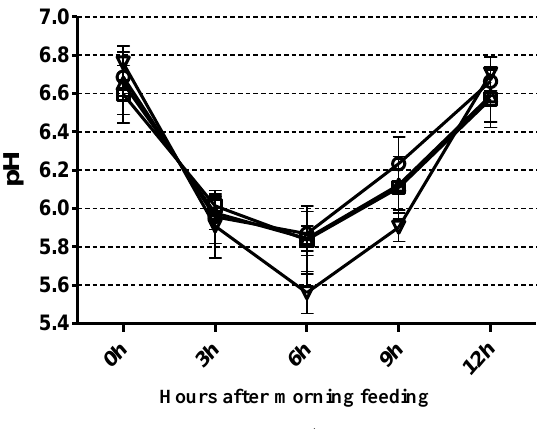
Figure 1. Diurnal patterns of rumen pH as influenced by dietary treatments. Error bar is